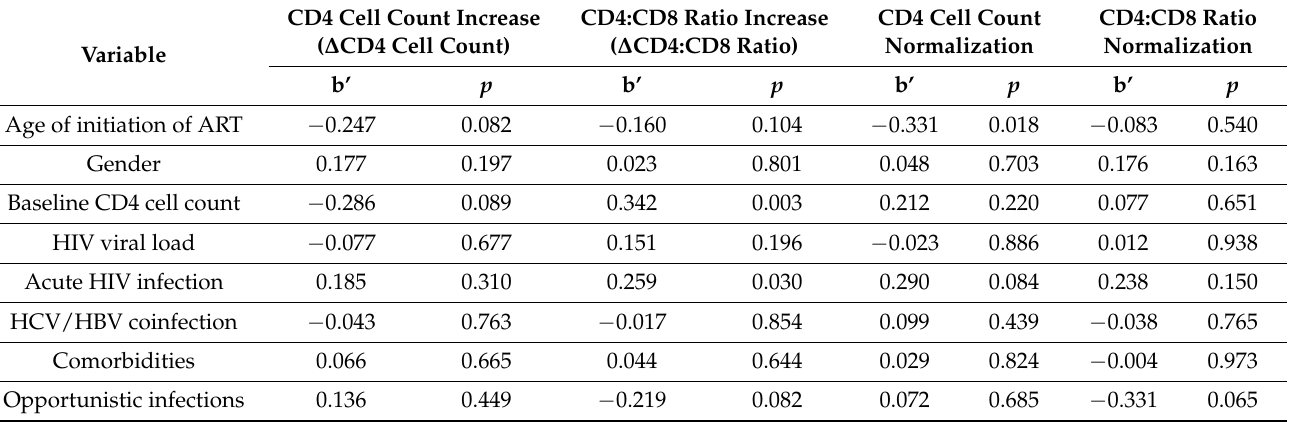
Table 5. The results of a generalized linear model for confounding factors for ∆ CD4 cell count and ∆ CD4:CD8 ratio and